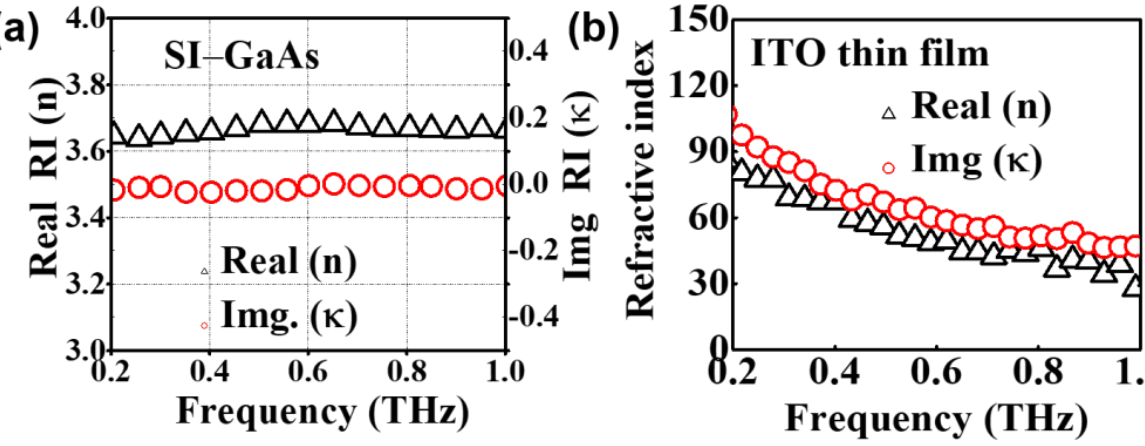
Figure 4. The real ( n ) and imaginary ( κ ) refractive indices as function of THz frequencies for ( a ) SI − GaAs and ( b ) ITO thin film.